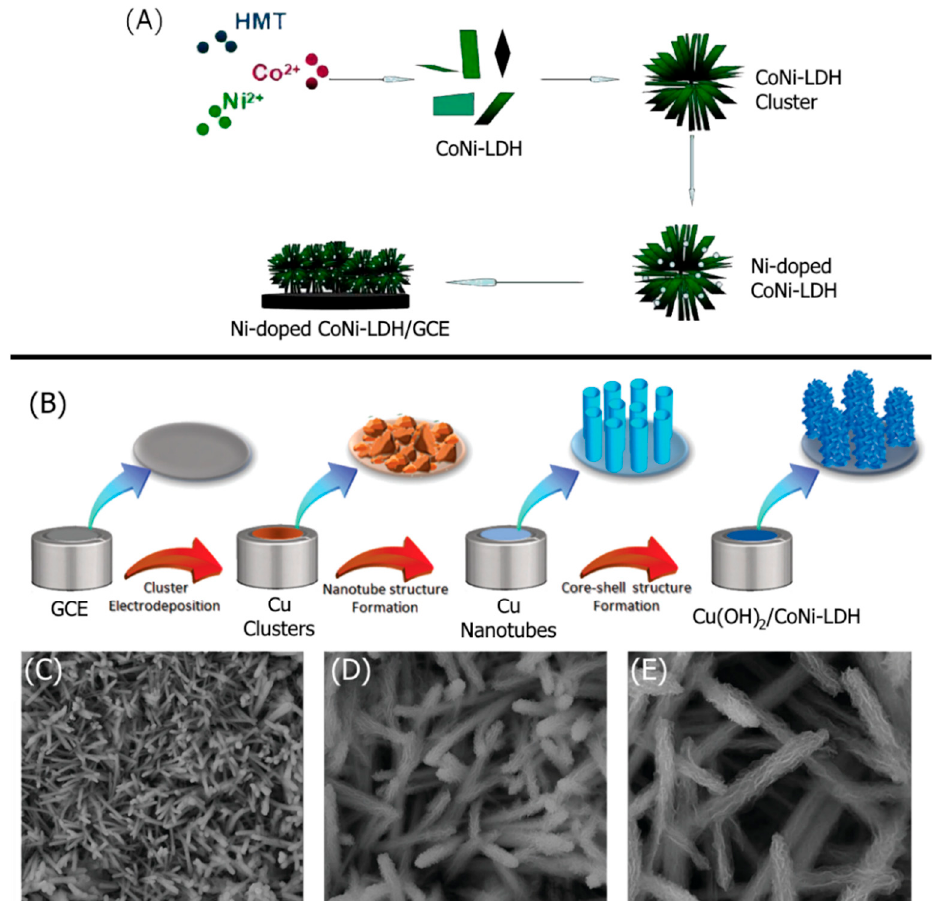
Figure 4. Schematic illustration of the fabrication of ( A ) Ni-doped CoNi-LDH on GCE, reproduced from reference [116], with permission from Wiley, 2016 and ( B ) Cu(OH) 2 /CoNi-LDH; ( C – E ) SEM micrographs of the Cu(OH) 2 /CoNi-LDH at increasing magnifications, reproduced from reference [48] with permission from The Royal Society of Chemistry, 2019.